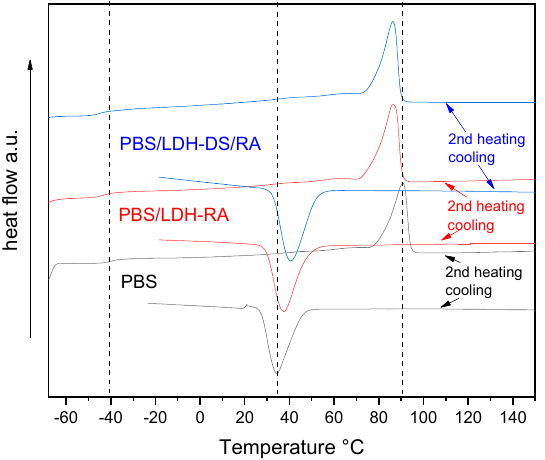
Figure 9. DSC curves (2 nd heating and cooling) of PBS, PBS/LDH-RA, and PBS/LDH-DS/RA. Dashed lines indicate the fundamental transitions of pure PBS: glass transition, crystallization, and melting.